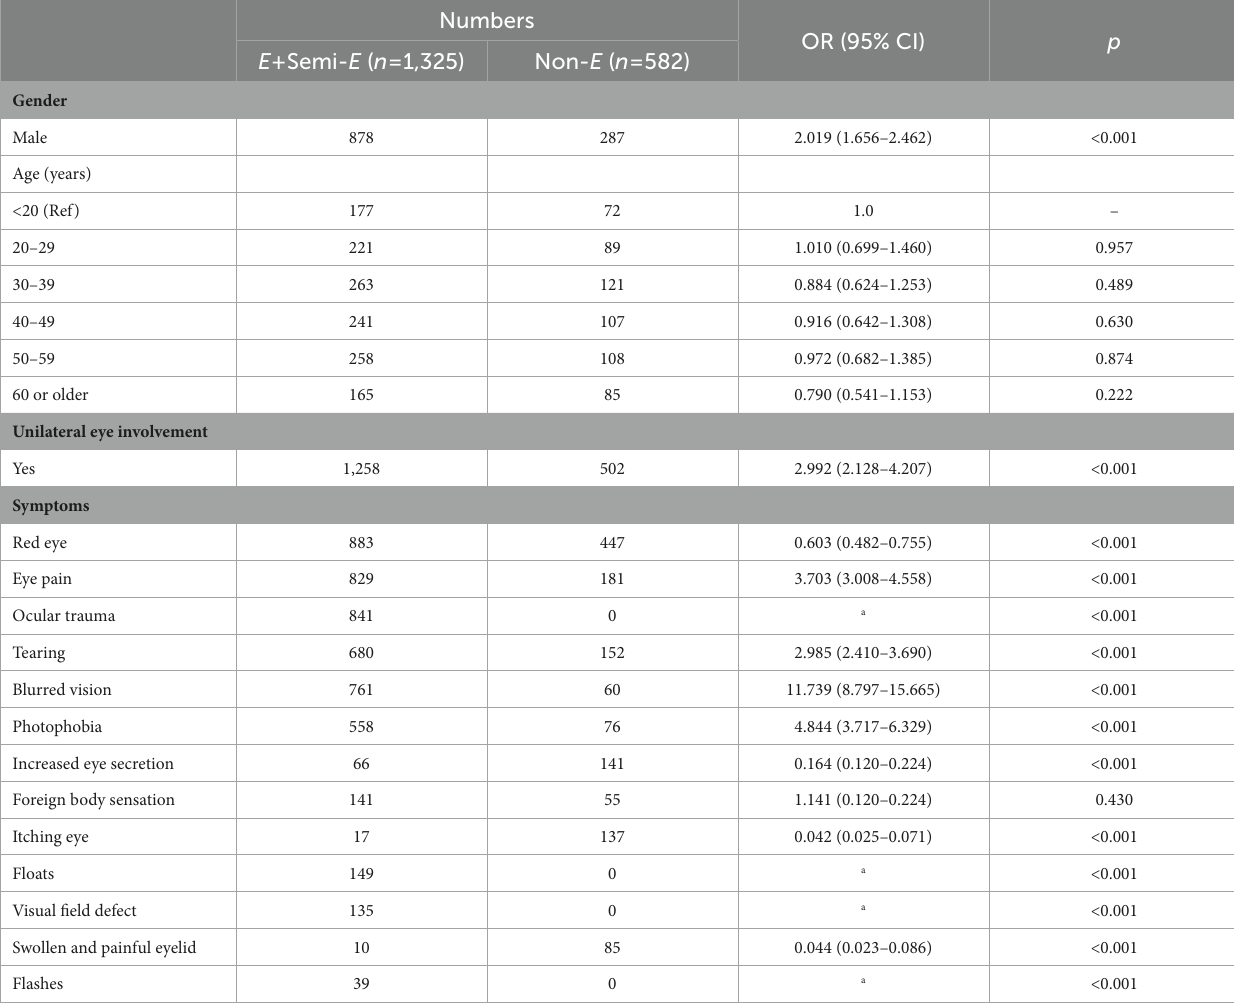
TABLE 2 Binary logistic regression to assess characteristics associated with true urgency.